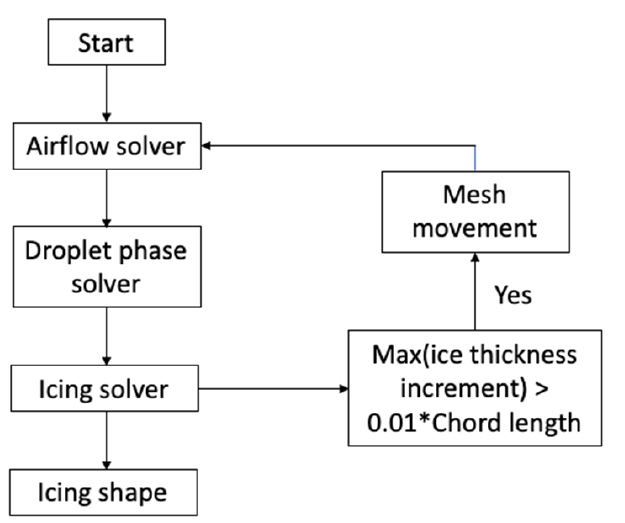
Figure 2. Ice accretion numerical modeling framework (* represents product of 0.01 and chord length).